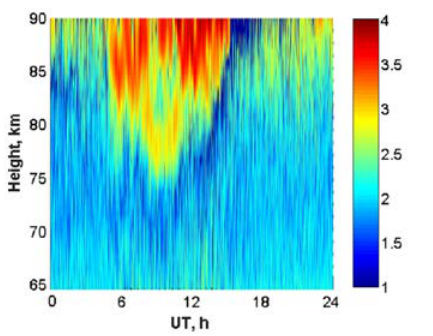
Fig. 2. An example of measuring of the electron density Lg( N e ) (cm -3 ) 13 March